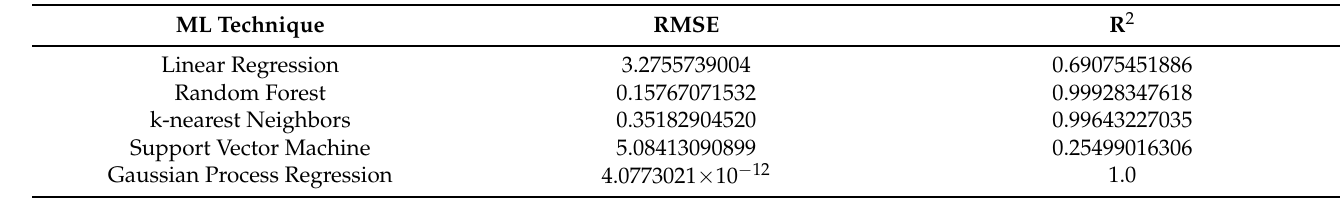
Table 15. Temperature results for the suspended particulate matter measuring